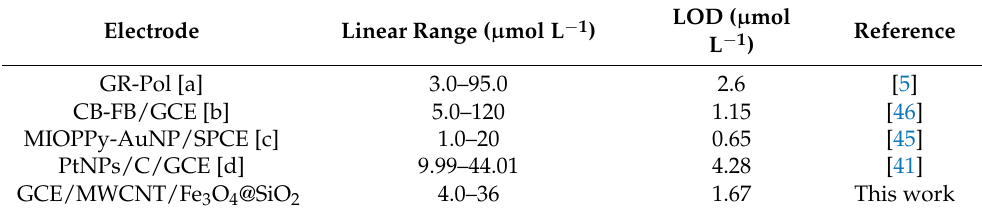
Table 2. Comparison of the proposed sensor with other methods described in the literature.